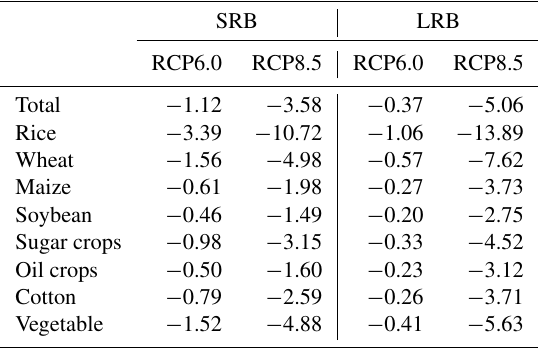
Table 4. Percentage change in total profits under two climate sce- narios without optimization in 2030 (compared with the reference scenario,